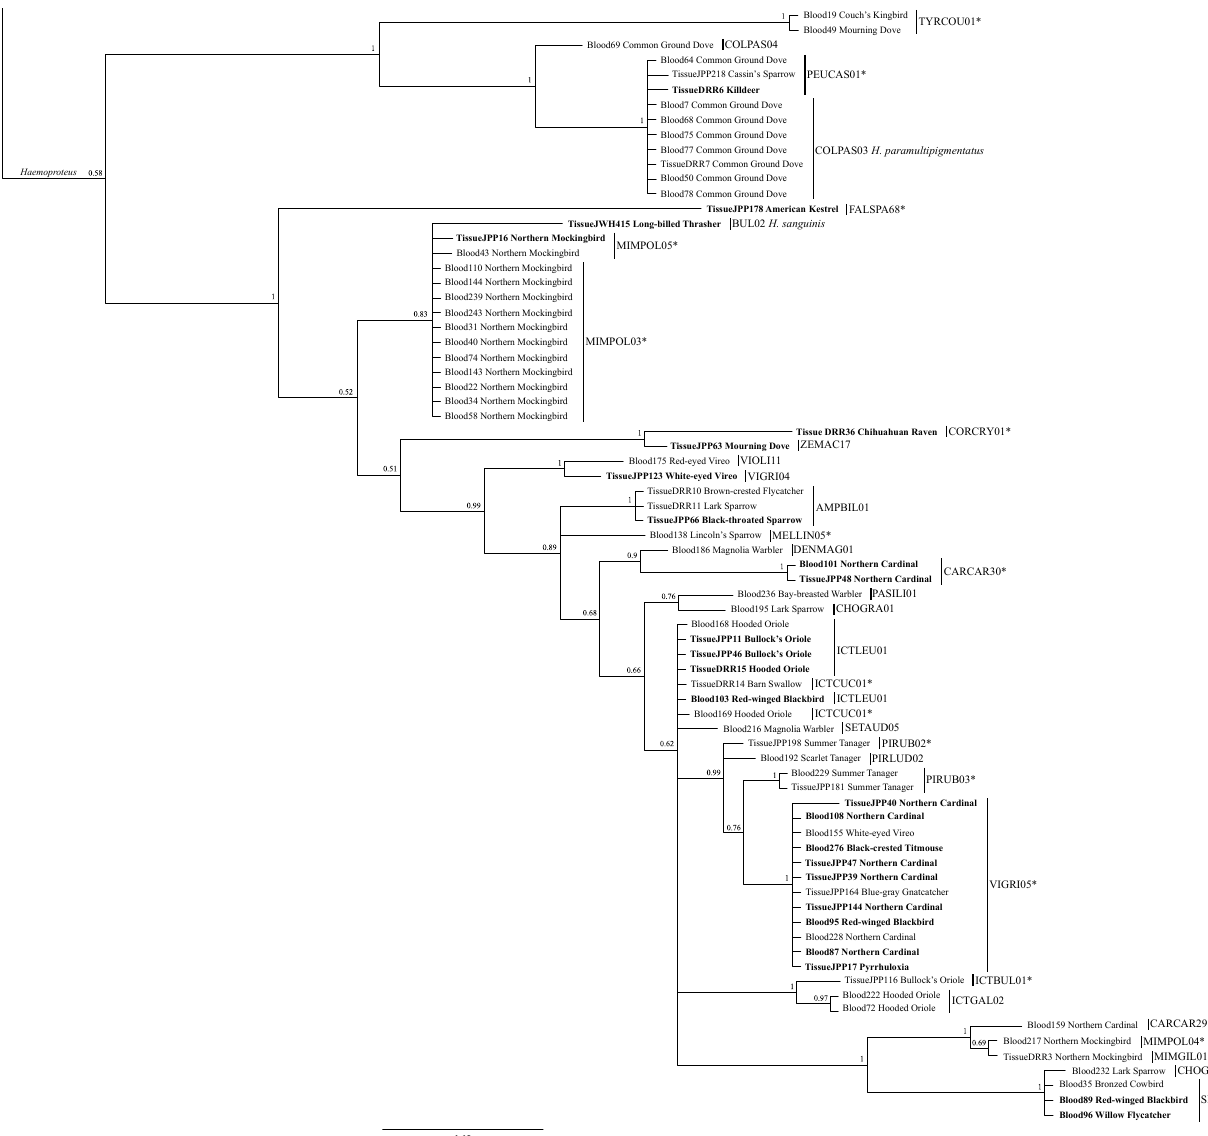
Figure 3. Bayesian analysis of all Haemoproteus sequences collected from blood and tissue in this study. Bold text indicates samples from SAV, and regular weight text refers to ES samples. Asterisks indicate sequence greater than 1 bp and 99% or less similarity with MalAvi closest match, and which were given new lineage designations.